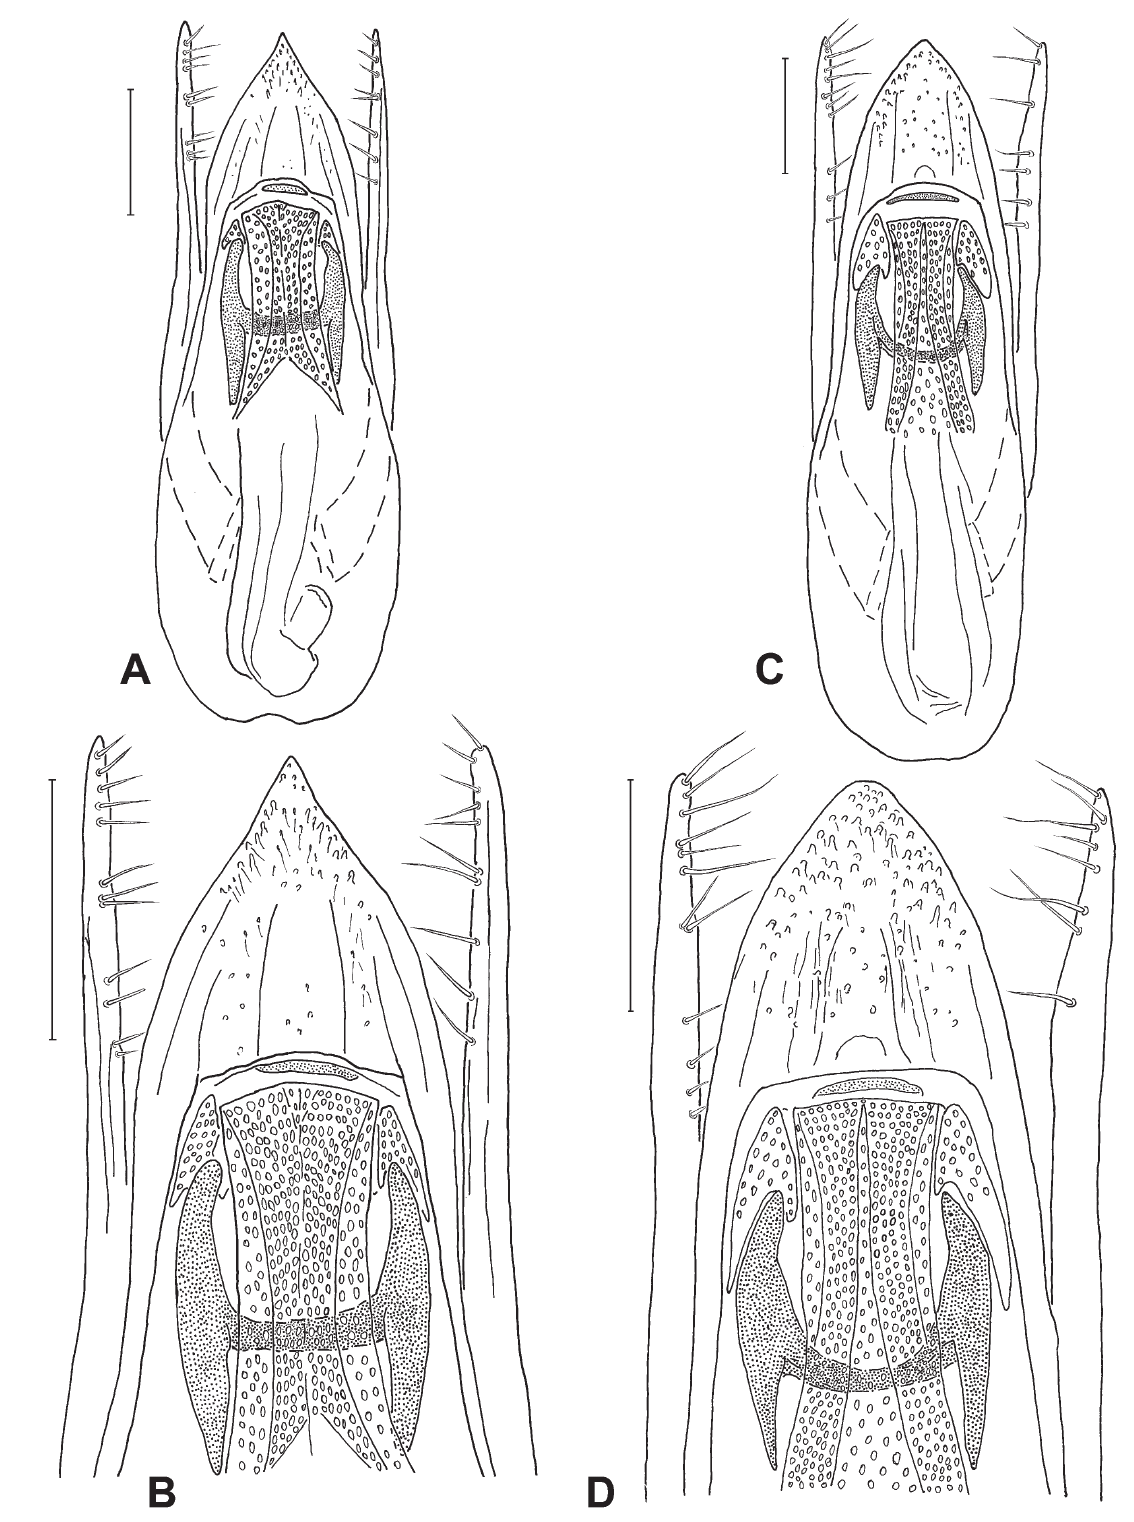
Fig. 4. – A–B : Stenus ( Nestus ) canosus sp. nov.: ♂ (holotype). A . Aedeagus, ventral view. B . Apical part of aedeagus, ventral view. – C–D : S. ( N. ) canalis sp. nov.: ♂ (holotype). C . Aedeagus, ventral view. D . Apical part of aedeagus, ventral view. [Note that the difference in shape of the apical lobe compared to that in C is due to the level of magnification.] – Scales = 0.1